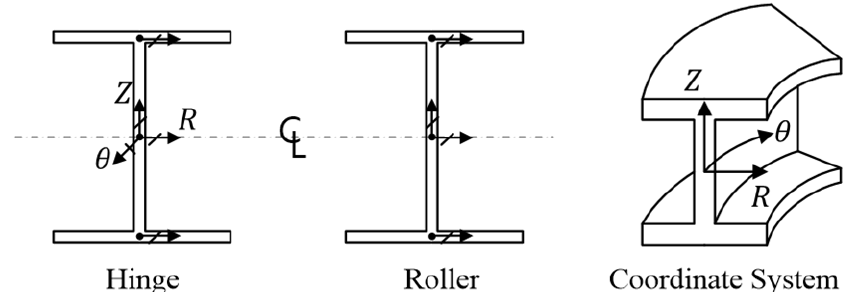
Figure 1. Loading Condition; End Moment.